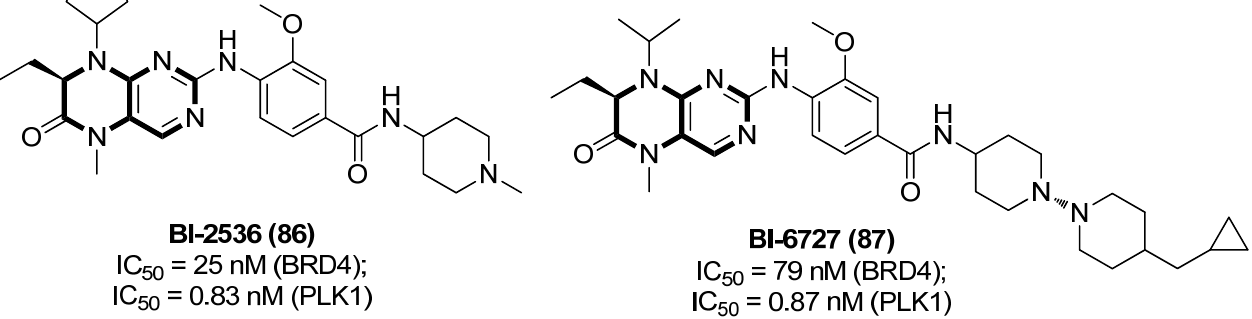
Figure 17. Pteridine-based PLK1/BET dual inhibitors 86 and 87 as